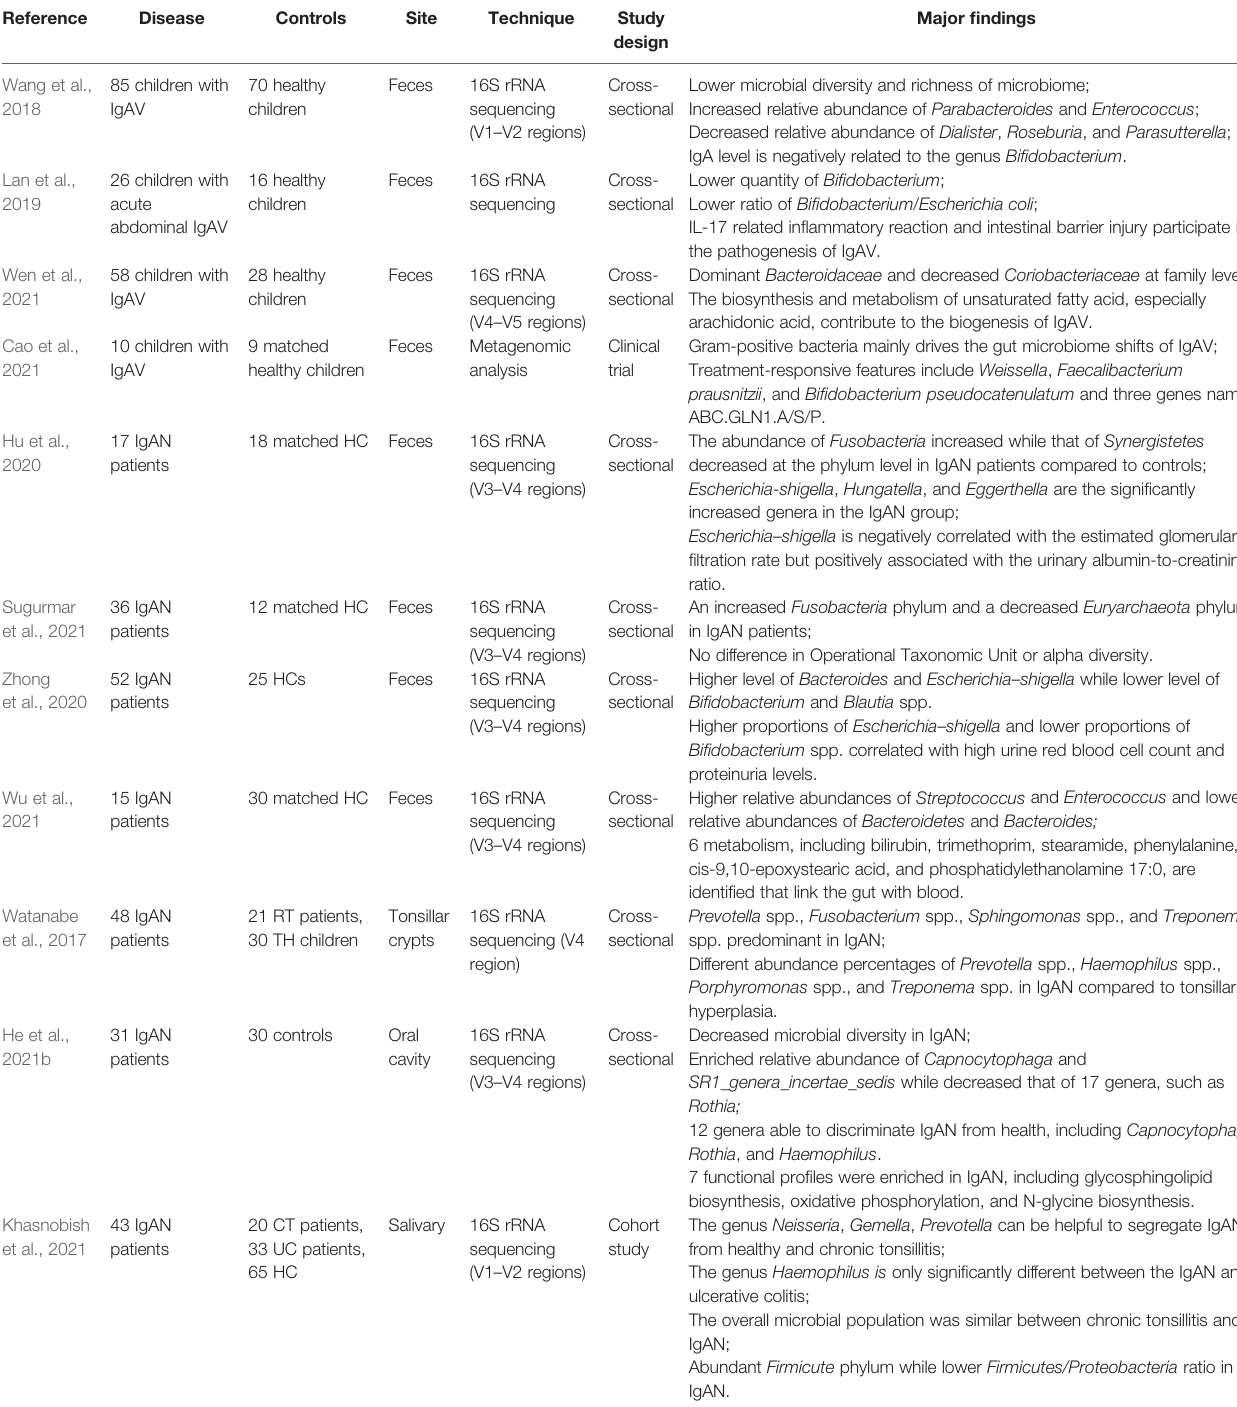
TABLE 1 | Summary of microbiome studies in